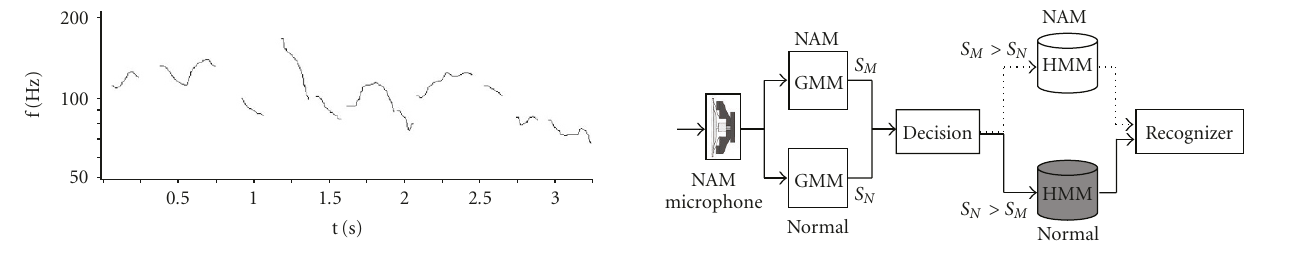
Figure 21: GMM-based discrimination.